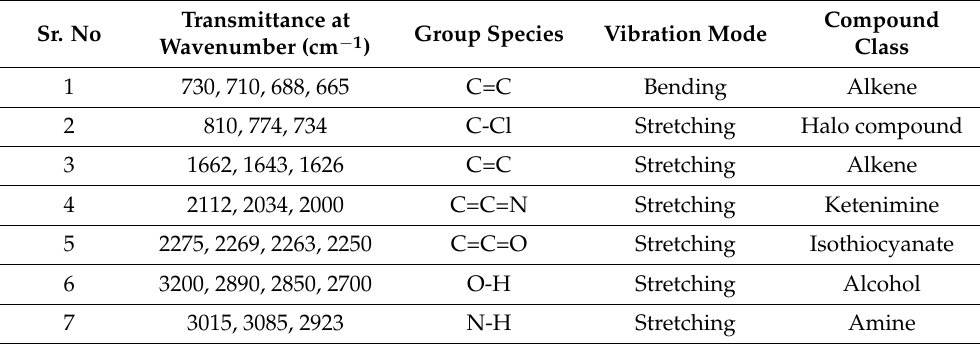
Table 3. FTIR analysis of the functional groups of degraded byproducts of DCF sodium using the Fe 2+ /H 2 O 2 process.